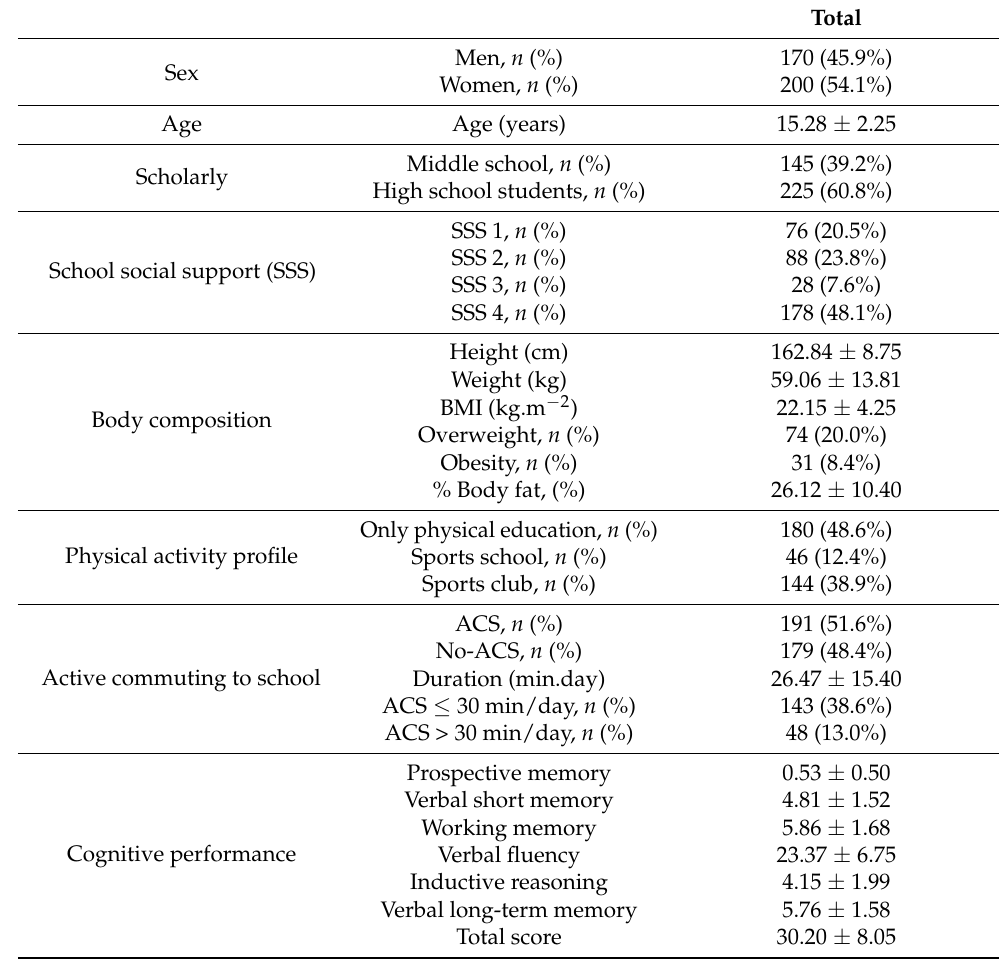
Table 2. The adolescents’ characteristics ( n =